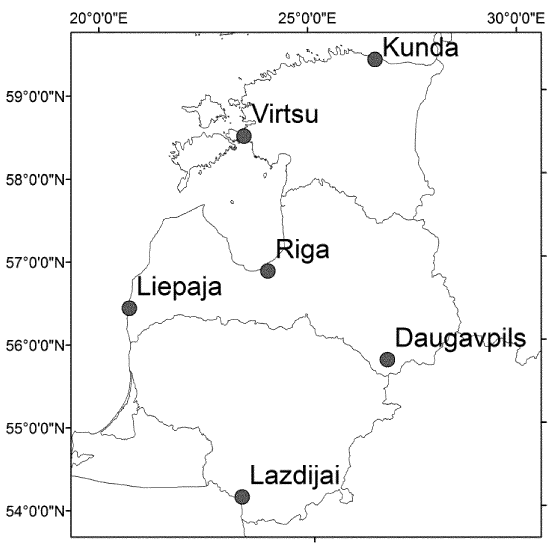
Fig. 7. Stations representing coastal or inland climate, used in further analysis.